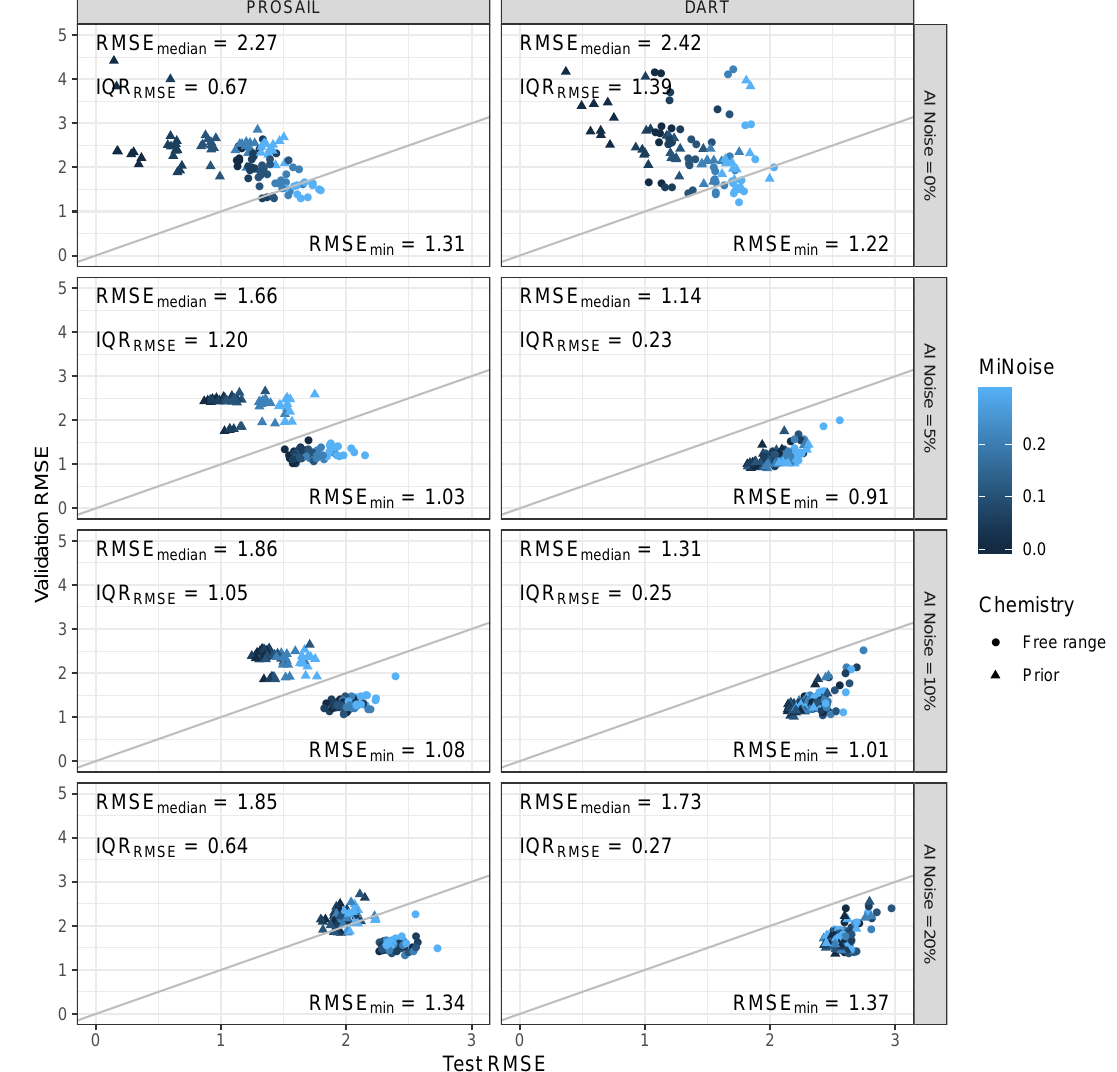
Figure 9. Prediction performance in terms of testing and validation RMSE with dependence on the chosen RTM, AI and MI noise level, and bio-chemical prior. RMSE median , IQR RMSE and RMSE min refer to the validation error in the respective panel cell. Grey line is 1:1 line. In case of the validation results, 14 realisations were trimmed with RMSE larger than 10m 2 m − 2 (all with 0% AI noise) because they prevented proper